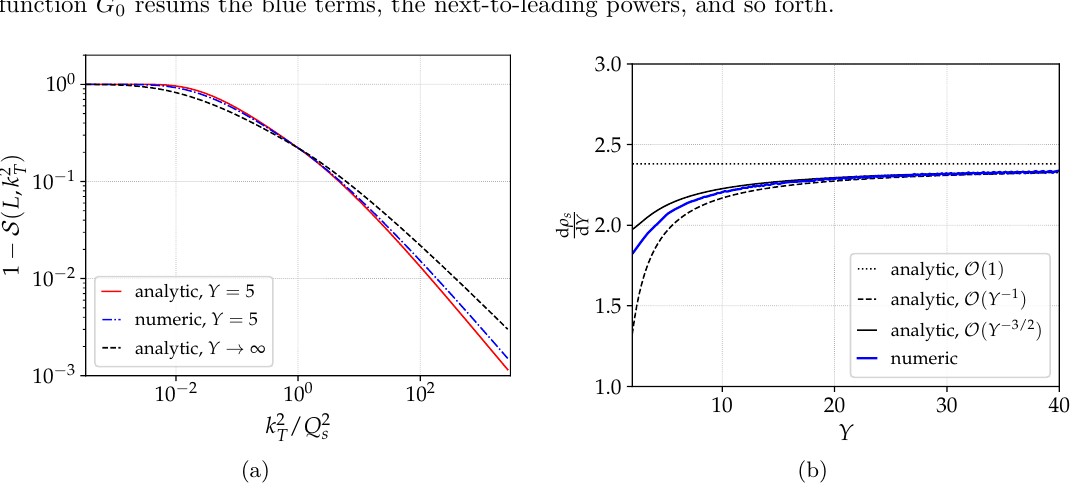
Figure 6. (Left) The function 1 − S ( Y, ρ ) in the rest frame of the front. (Right) The velocity of the front as function of time Y